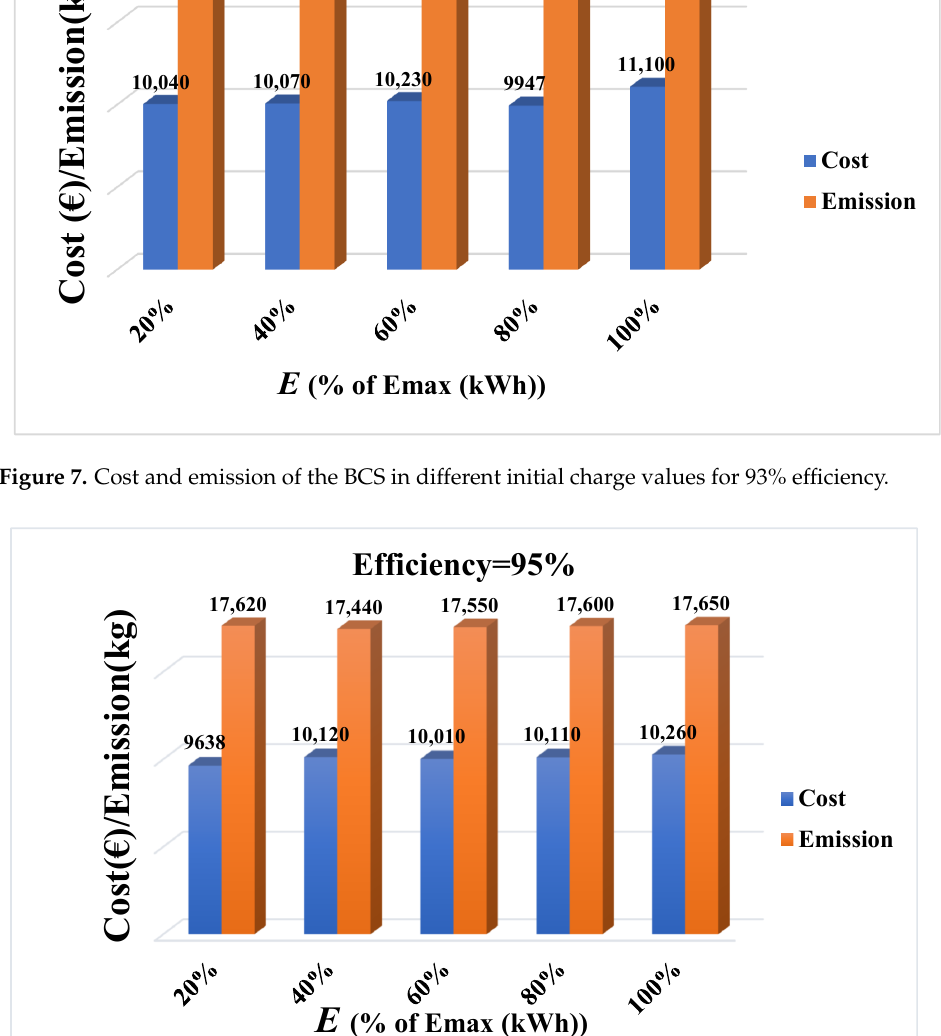
Figure 8. Cost and emission of the BCS in different initial charge values for 95% efficiency.